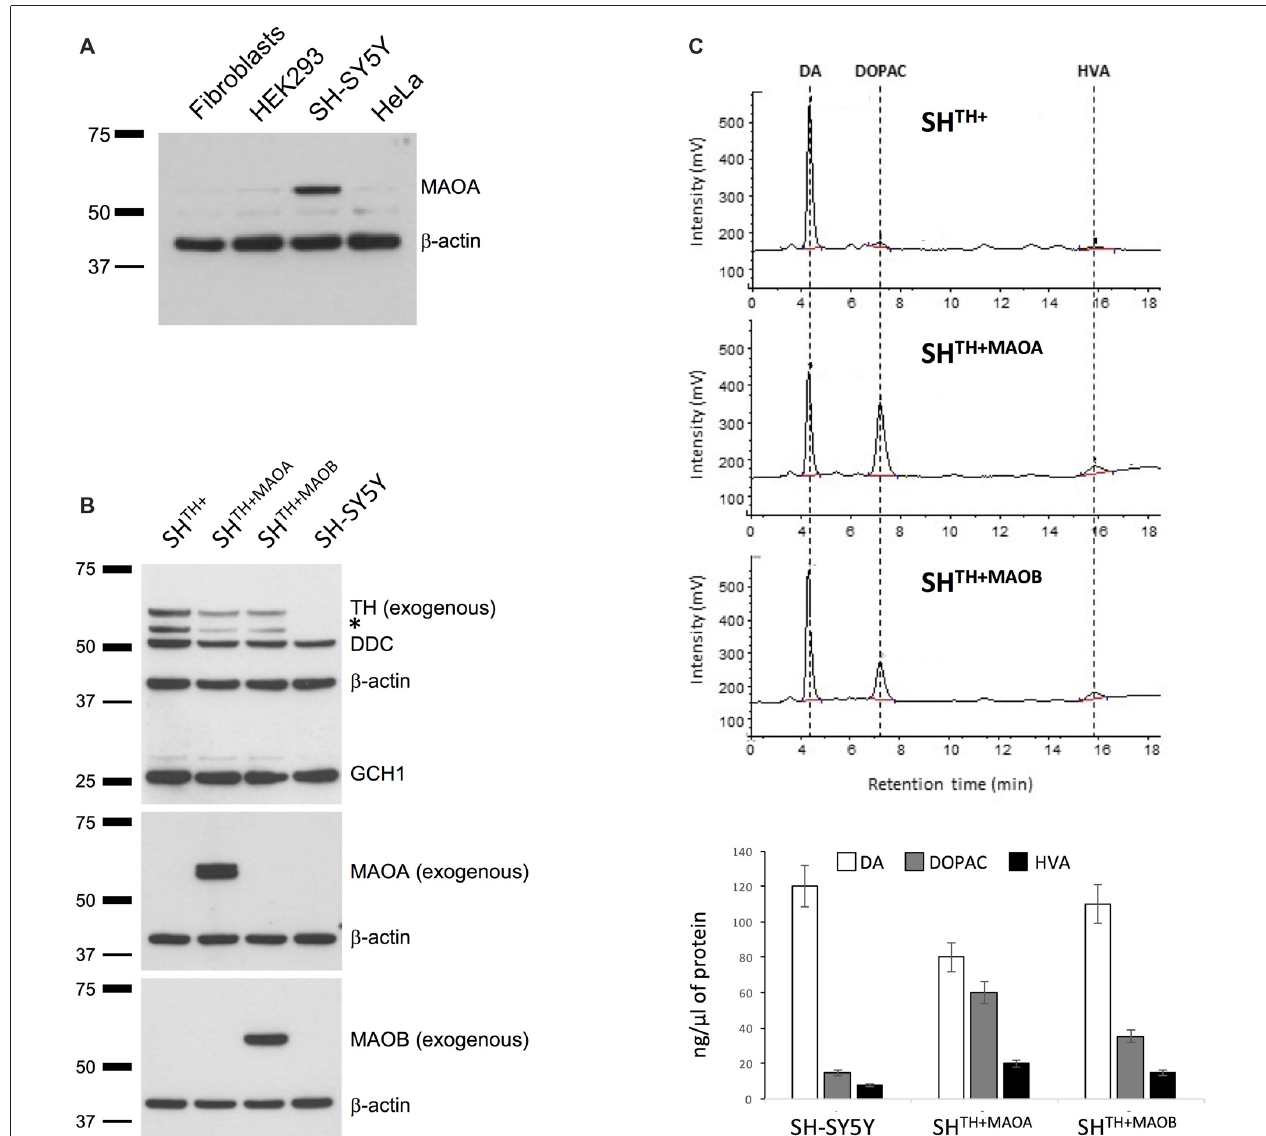
FIGURE 2 | Monoamino oxidase A (MAOA) is expressed in SH-SY5Y cells. (A) Western blot analysis of MAOA in human dermal fibroblasts, SH-SY5Y cells, and iPSC-derived neurons. β -actin served as a loading control. (B) Western blot analysis of SH-SY5Y cells coexpressing TH and either MAOA (SH TH + MAOA ) or MAOB (SH TH + MAOA ). Naive SH-SY5Y and SH-SY5Y cells expressing TH only (SH TH + ) served as controls. (C) High performance liquid chromatography (HPLC) analysis of DA, DOPAC, and HVA in SH TH + , SH TH + MAOA and SH TH + MAOB . TH, tyrosine hydroxylase; DA, dopamine; DOPAC, 3,4-dihydroxyphenylacetic acid; HVA, Homovanillic acid; ∗ non-specific